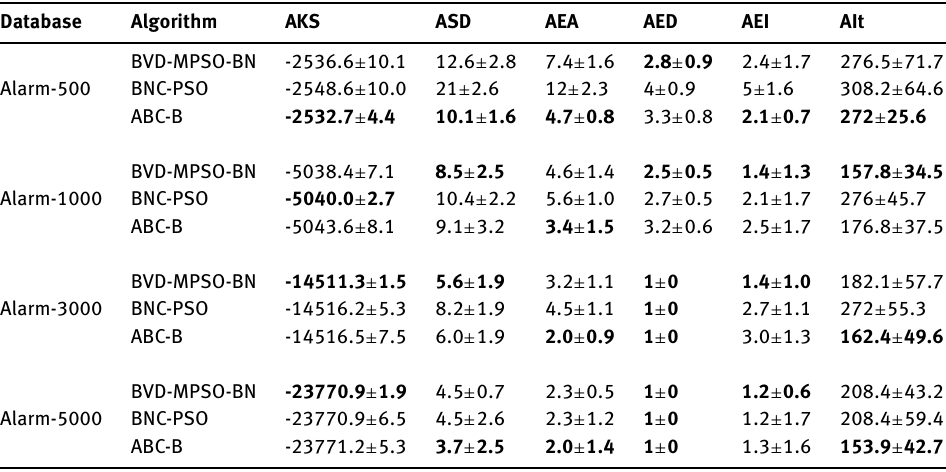
Table 4. The experimental results of three algorithms on Alarm network